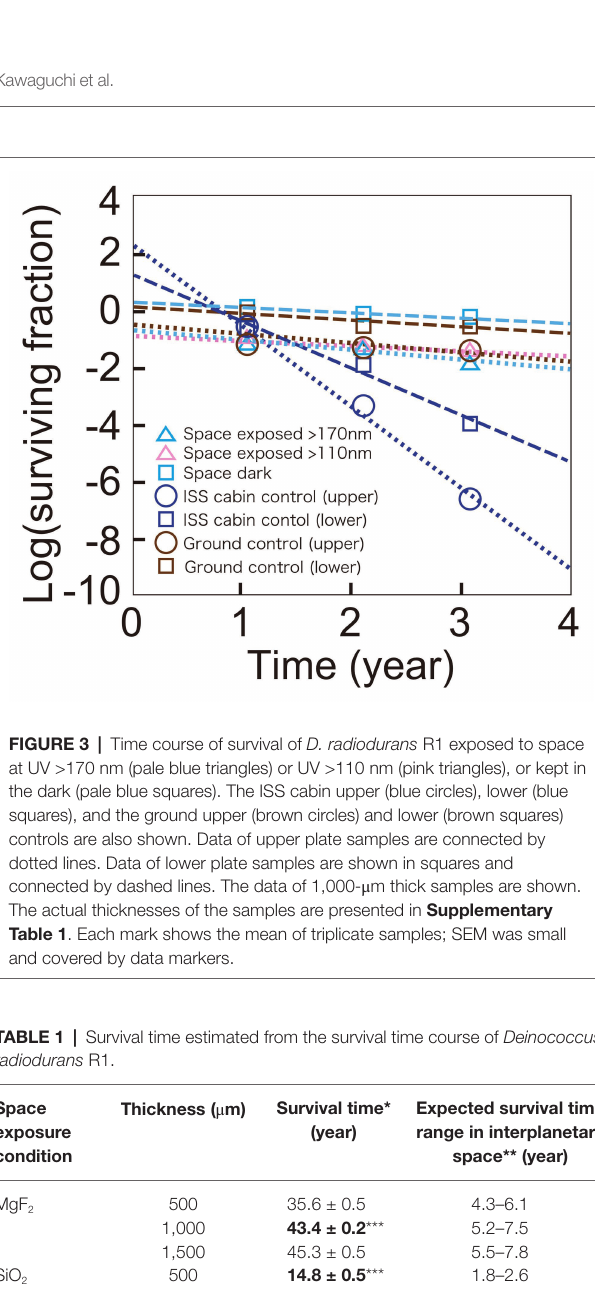
*Survival time with 95% probability was estimated from the survival time course and initial cell numbers ( Supplementary Table 2 ). **Expected survival time range was estimated from the survival time and the UV dose of the experiments (between 44 and 63 equivalent solar day (ESD)/year under MgF 2 window and between 41 and 58 ESD/year under quartz window in interplanetary space, Supplementary Table 4 ). ***Expected survival time with the R 2 (coefficient of determination) higher than 0.7 ( Supplementary Table 5 ) is shown in bold